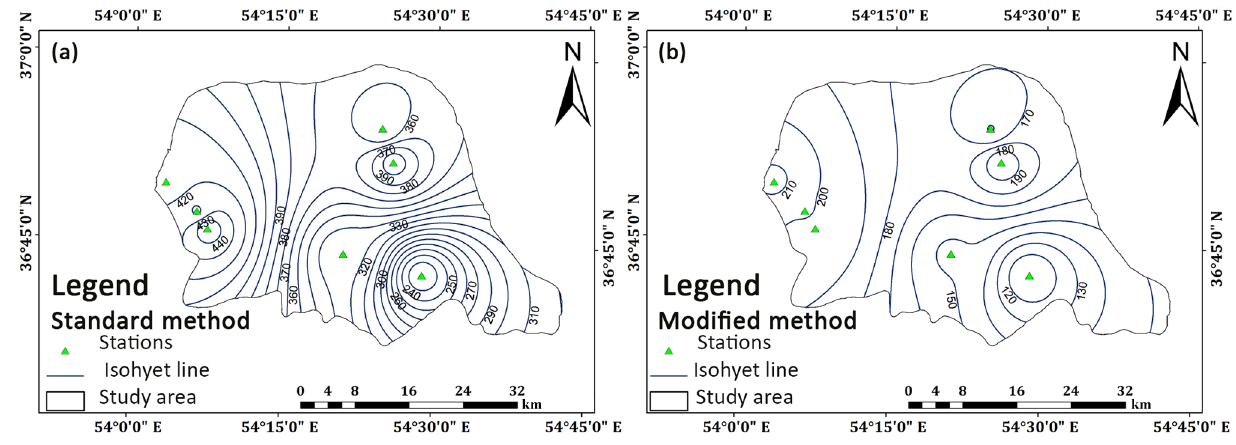
Figure 2. The spatial distribution of PMP 24 using (a) standard and (b) modified approaches in the study area.